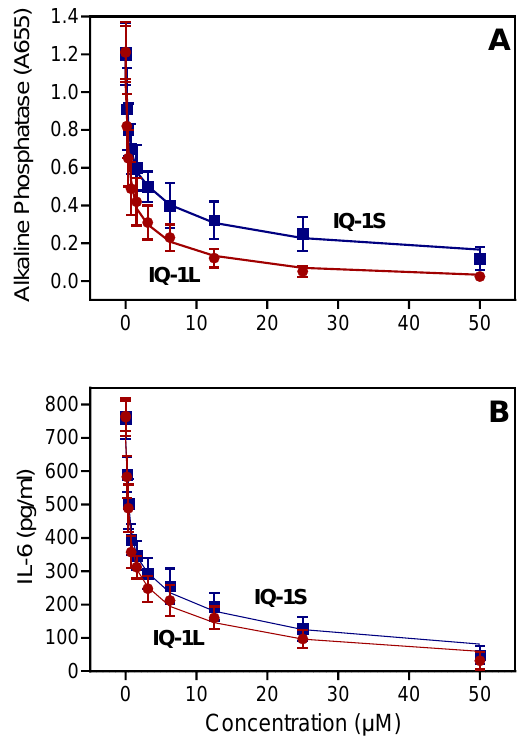
Figure 3. Effect of IQ-1L and IQ-1S on NF- κ B/AP-1 activity and IL-6 production. ( A ) THP-1Blue cells were pretreated with the indicated compounds or DMSO for 30 min, followed by addition of 250 ng/mL LPS or buffer for 24 h. NF-kB/AP-1 activity was monitored by measuring secreted alkaline phosphatase activity spectrophotometrically in the cell supernatants (absorbance at 655 nm). ( B ) MonoMac-6 cells were pretreated with the indicated compounds or DMSO for 30 min, followed by addition of 250 ng/mL LPS or buffer for 24 h. Production of IL-6 in the supernatants was evaluated by ELISA. The data in each panel are presented as the mean ± S.D. of triplicate samples from one experiment that is representative of three independent experiments.